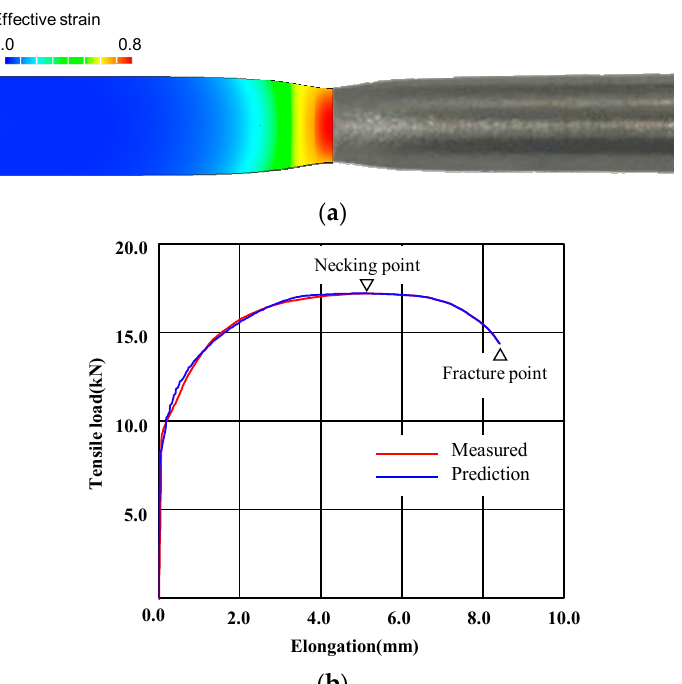
Figure 7. Comparison of predicted and experimental tensile test results: ( a ) shape after the fracture and ( b ) tensile load-elongation curve.